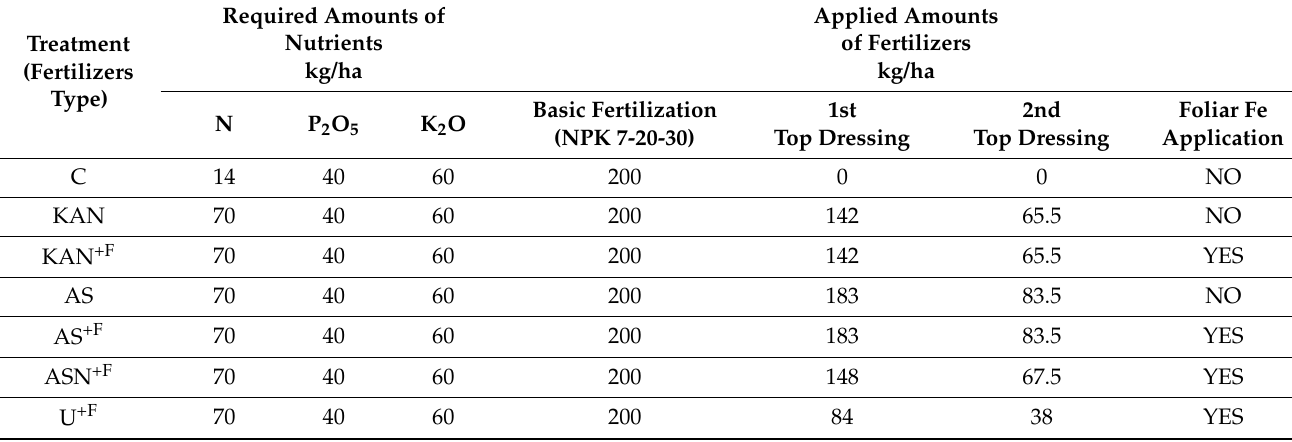
Table 1. Fertilizer type, required amounts of nutrients (kg/ha) and applied amounts of fertilizers.